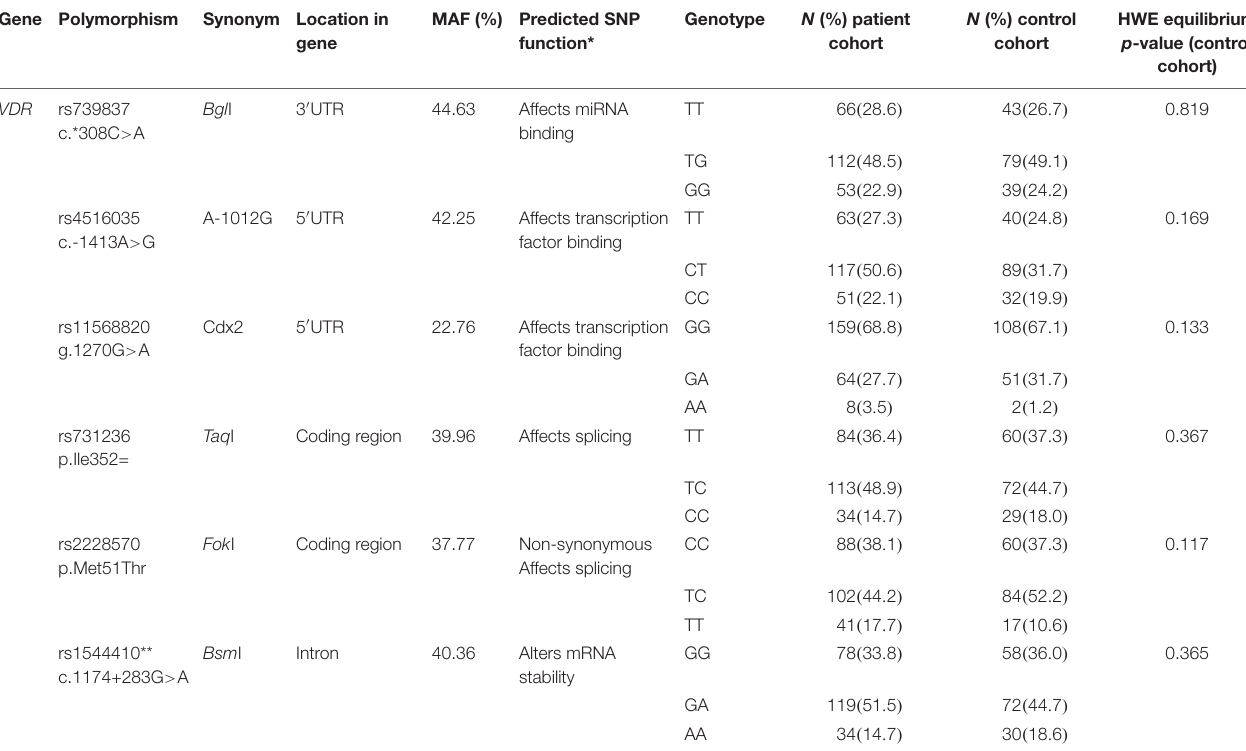
TABLE 1 | Genotype frequencies and characteristics of the genetic variants studied in our PD cohort. Gene Polymorphism Synonym Location in